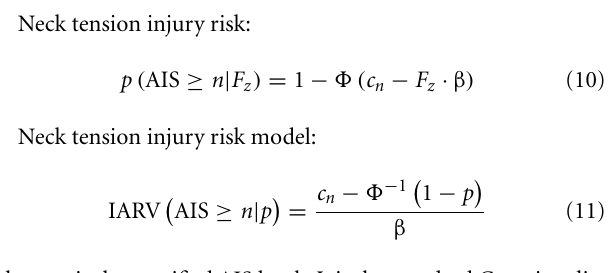
Philippens et al. (2011)